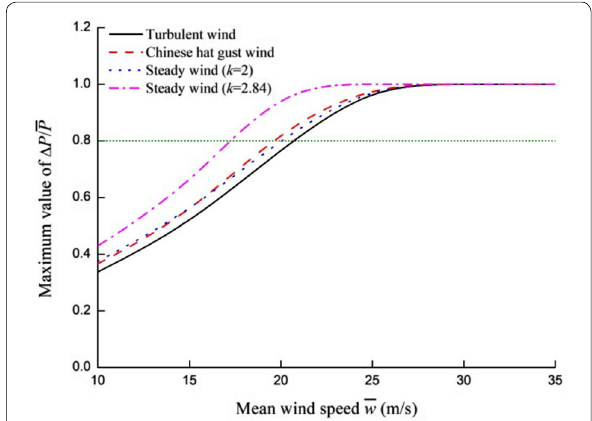
Figure 13 Maximum value of load reduction factor